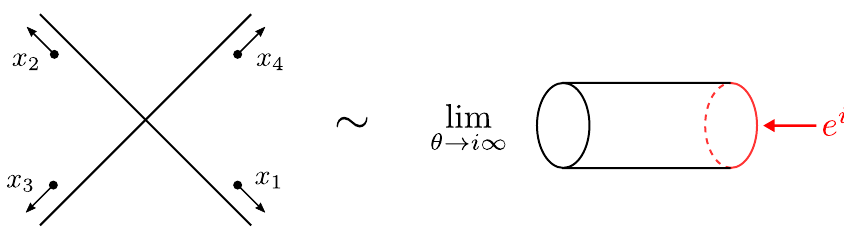
Figure 38 . The Regge limit of the four-point function and the cylinder partition function. From the worldsheet point of view, the Regge limit corresponds to the limit in which the twist angle goes to i 1